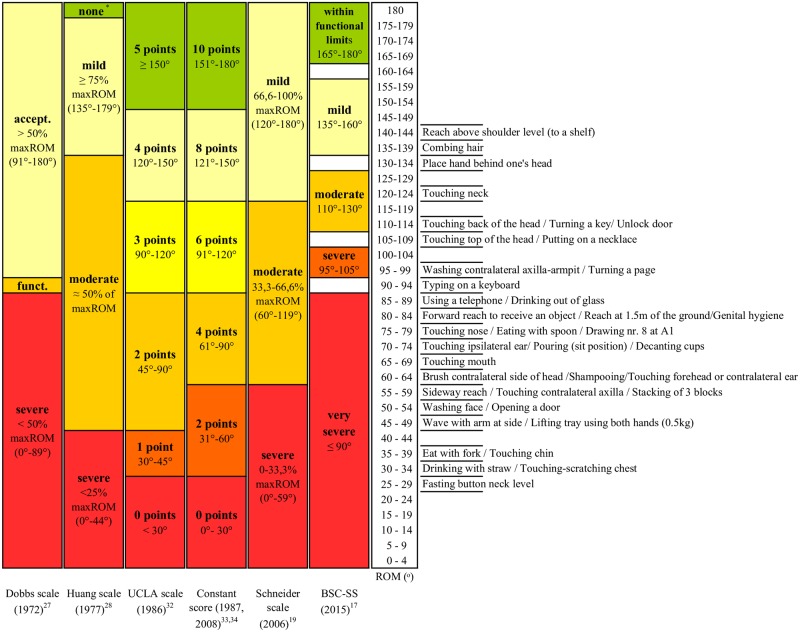
Schematic illustration of shoulder flexion rating scales and their cut-off points per degrees of Range of Motion (ROM) as well as required shoulder flexion ROM for activities of daily life (ADL) as synthesized by Oosterwijk et al. [29–30].BSC-SS: Burn scar contracture severity scale; accept.: acceptable; funct.: functional = about 50% max ROM; *: none = no limitation of motion.